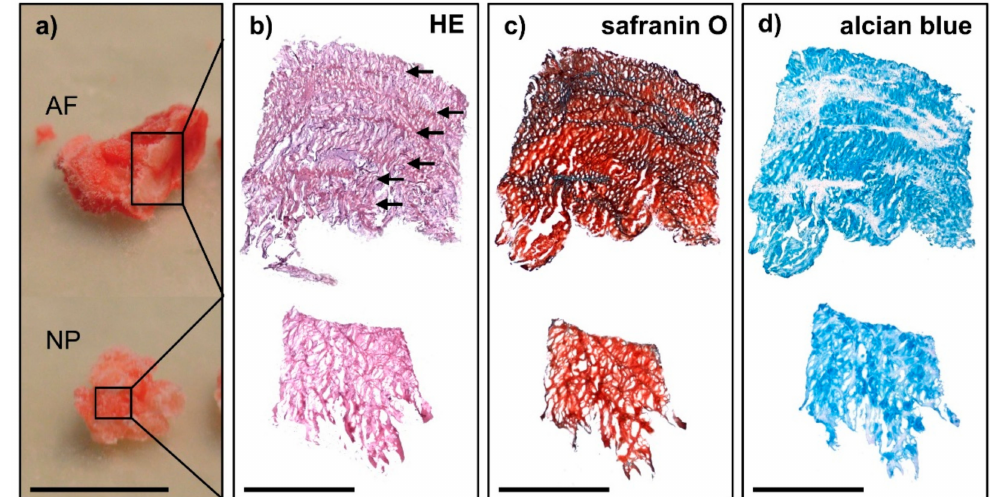
Figure 1. Exemplary small-sized tissue samples that showed the appropriate tissue type of either annulus fibrosus (AF) or nucleus pulposus (NP) according to IVD scoring. ( a ) Macroscopic and ( b – d ) histological evaluation with ( b ) haematoxylin-eosin (HE) staining (fibres typical for AF are indicated by arrows), ( c ) safranin O staining (proteoglycans in red) and ( d ) alcian blue staining (proteoglycans in blue). Scale bar in ( a ) 10 mm and in ( b – d ) 1